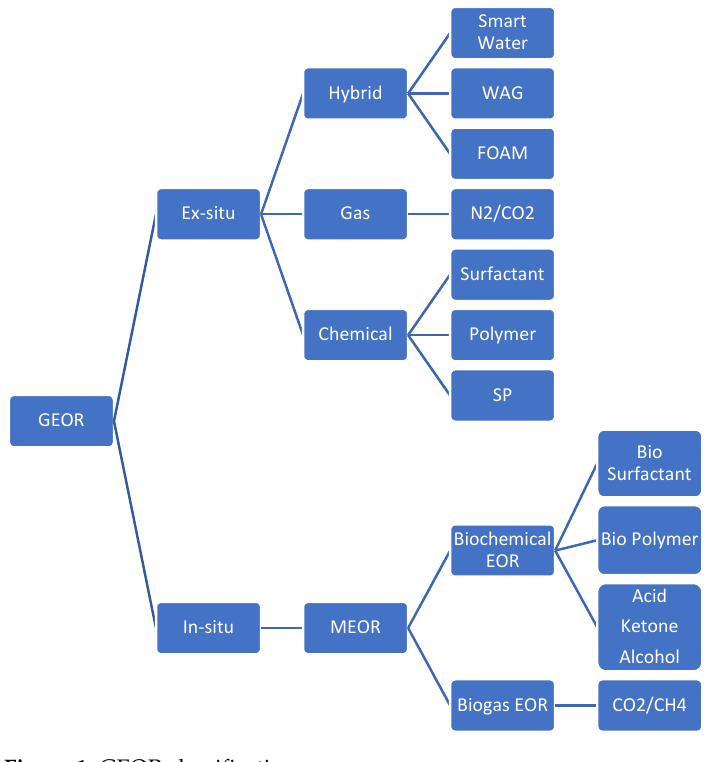
Figure 1. GEOR classification.